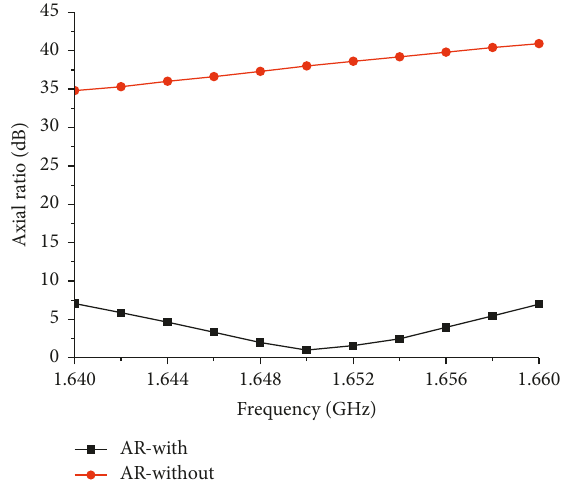
Figure 11: The comparisons of the ARs against frequency with and without the parasitic